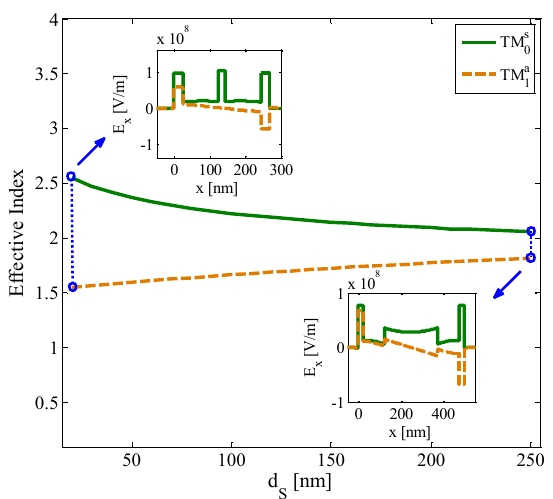
Figure 5: Effective refractive index and Normal electric field (E x ) profile of the first two TM polarized hybrid-guided modes of the HIMI slab waveguide in terms of d S for d H =100 nm and d L =25